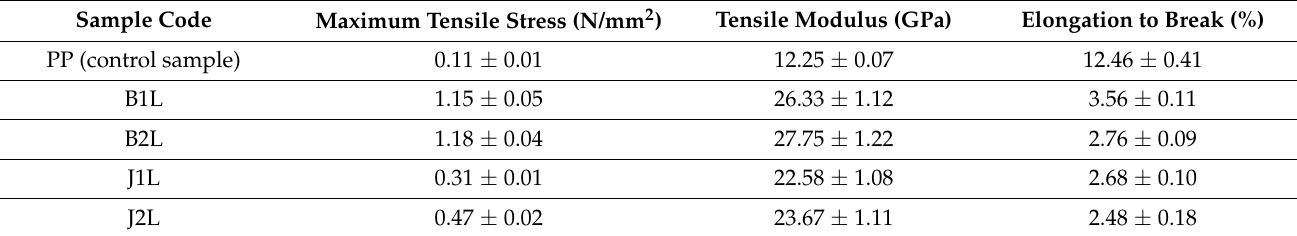
Table 4. The results of the tensile